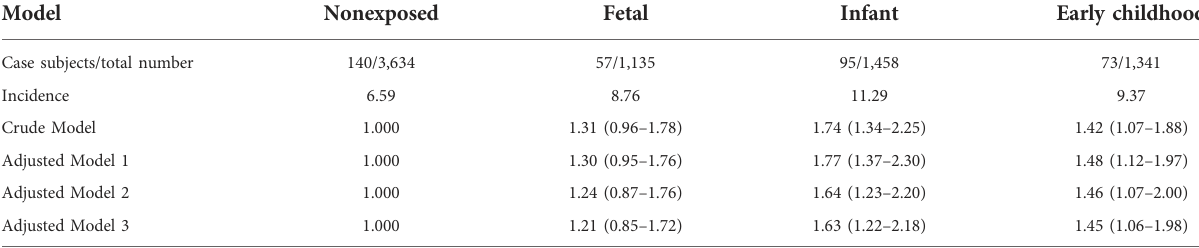
TABLE 5 Association between strati fi cation of earthquake exposure and risk of DM in adulthood.